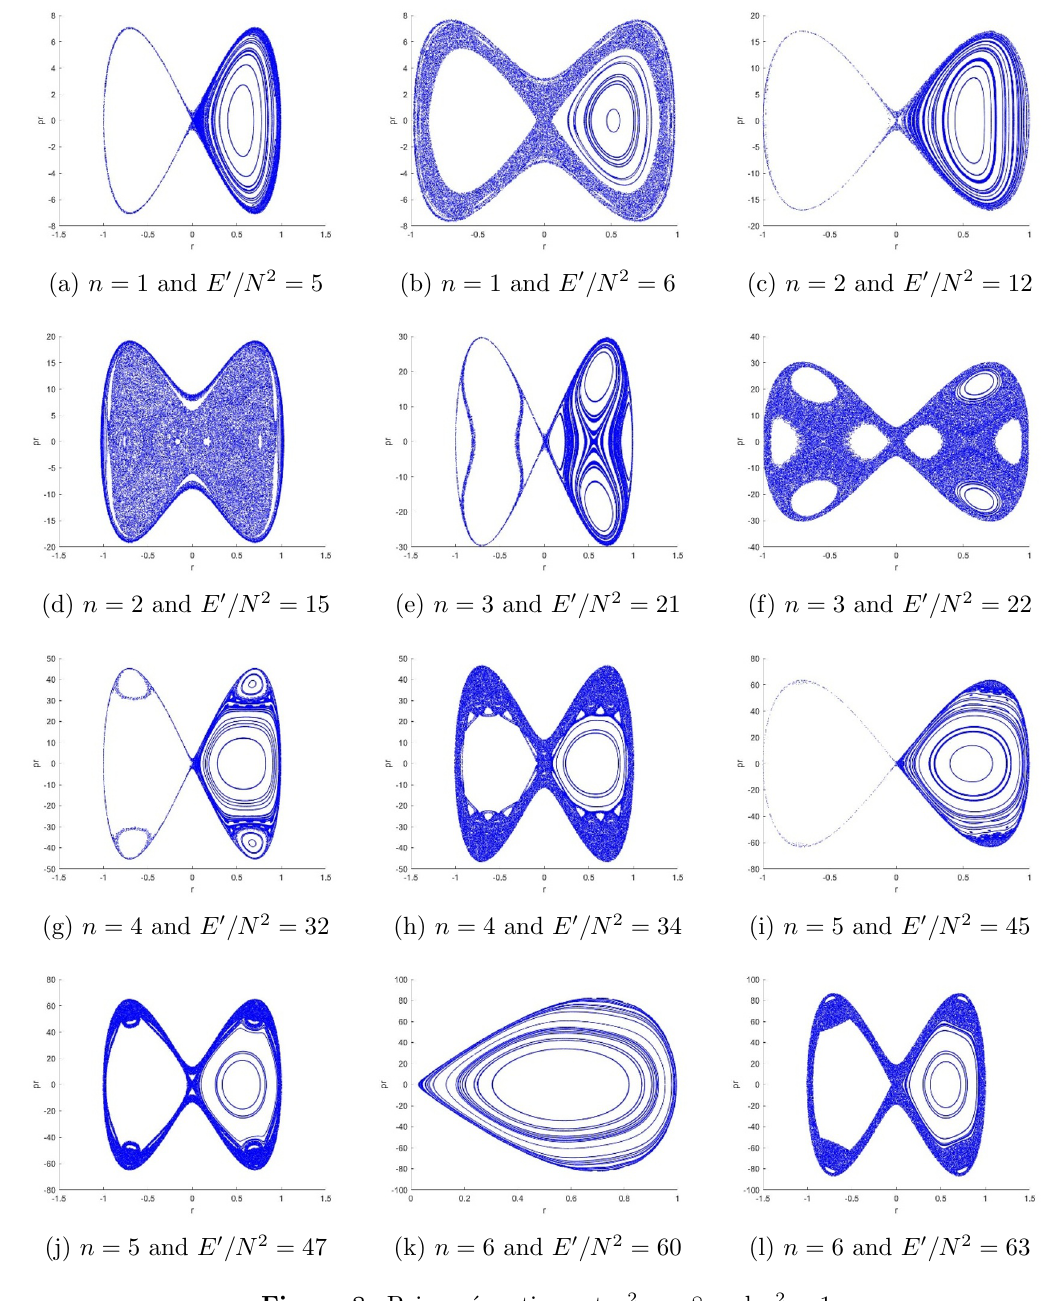
Figure 8. Poincar(cid:19)e sections at (cid:22) 2